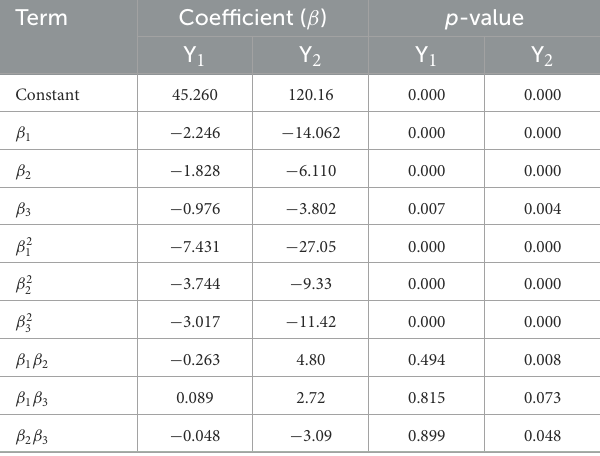
TABLE 3 Coded regression coefficient of both